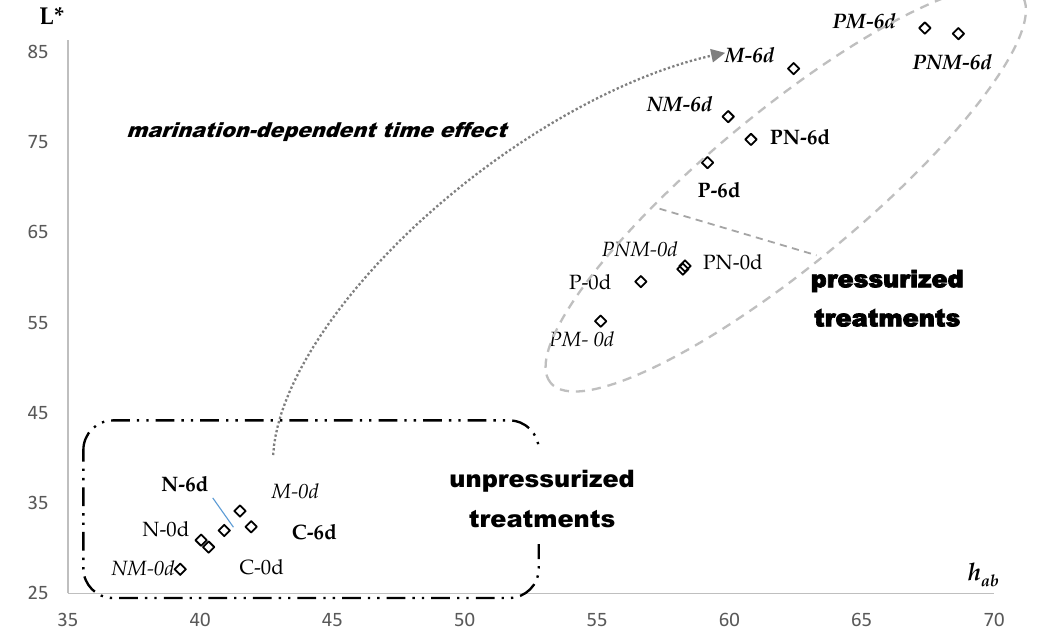
Figure 3. Beef color representation of L* and h ab as a function of the studied factors (pressure application, packaging type, marinate immersion and storage time). C: Control (unpressurized-LPDE 0%-unmarinated); N: Unpressurized-LPDE 5%-unmarinated; M: Unpressurized-LPDE 0%-marinated; NM: Unpressurized-LPDE 5%-marinated; P: Pressurized-LPDE 0%-unmarinated; PN: Pressurized-LPDE 5%-unmarinated; PM: Pressurized-LPDE 0%-marinated; PNM: Pressurized-LPDE 5%-marinated. Marinated treatments are in italics, and pressurized treatments are in bold.